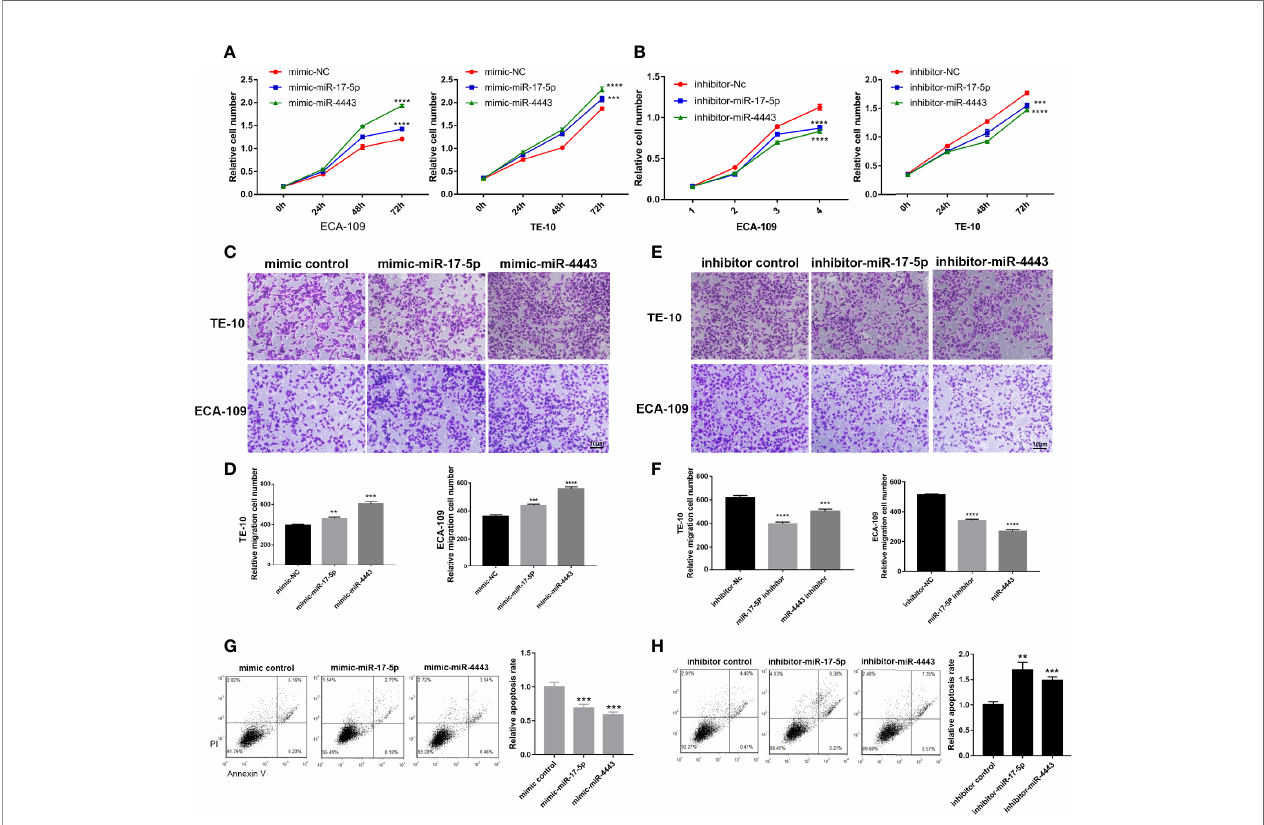
FIGURE 2 | Effect of miR-17-5p and miR-4443 in the regulation of proliferation and migration of ESCC cells. (A, B) CCK8 assays were performed at 0h, 24h, 48h and 72h after the transfection of the ECA-109 cells and TE-10 cells with mimic-NC, mimic-miR-17-5p, mimic-miR-4443, inhibitor-NC, inhibitor-miR-17-5p and inhibitor-miR-4443. (C, D) Transwell analysis of the migration rate of ECA-109 and TE-10 cells transfected with an equal dose of mimic-NC, mimic-miR-17- 5p, mimic-miR-4443. (C) , representative image; (D) , quantitative analysis. (E, F) Transwell analysis of the migration rate of ECA-109 and TE-10 cells transfected with equal dose of inhibitor-NC, inhibitor-miR-17-5p and inhibitor-miR-4443. (E) , representative image; (F) , quantitative analysis. (G, H) Analysis of apoptosis in TE-10 cells treated with mimic control, mimic-miR-17-5p, mimic-miR-4443, inhibitor control, inhibitor-miR-17-5p and inhibitor-miR-4443. The total apoptotic cells were counted as the sum of early apoptotic (PI − AV+) and late apoptotic (PI+ AV+) cells (left: representative image; right: quantitative analysis). **P < 0.01, ***P < 0.001, ****P <